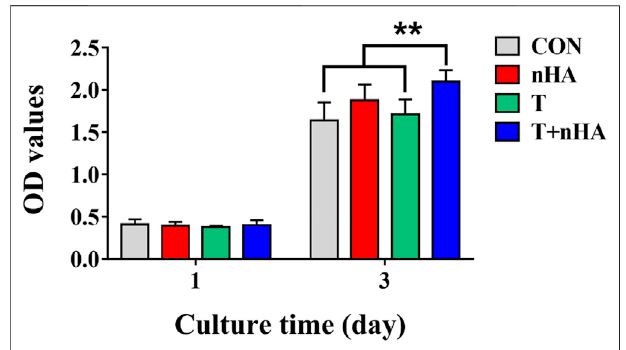
FIGURE 5 | MC3T3-E1 cells viability on various samples for 1 and 3 days. ** represents p <